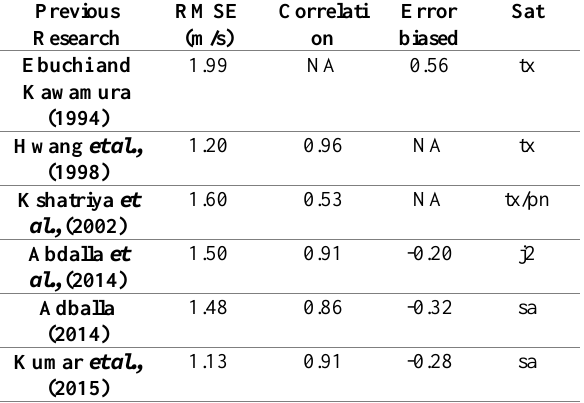
Table 1. Previous research findings of the comparisons between altimeter and buoy